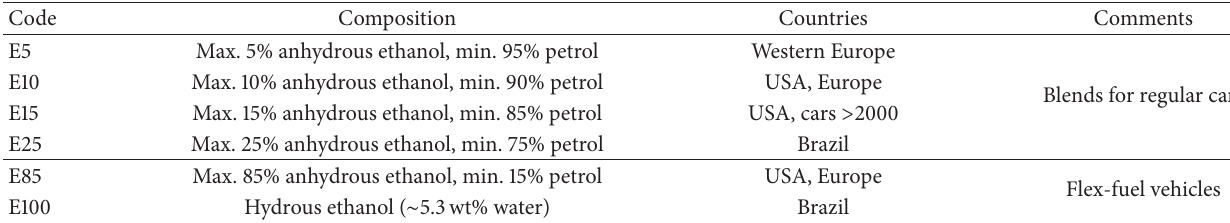
Table 1: Common ethanol-petrol mixtures [1,